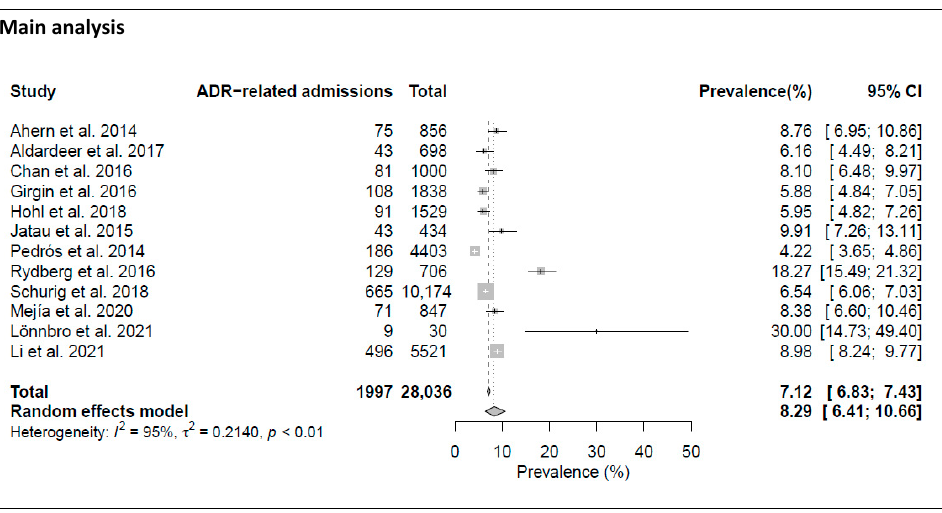
Figure 3. Forest plot of the pooled prevalence of ADE-related admissions to EDs or inpatient wards [35,39,40,42,43] . 3.6. Preventability of ADRs/ADEs Five studies found ADR preventability rates ranging from 24.0% to 97.6%, while three studies found ADE preventability rates ranging from 65.3% to 73.7% (Table 1). Preventability of ADR-related admissions . Figure 4 shows that the meta-analysis of four studies found an ADR preventability rate of 44.7% (95% CI, 28.1–62.4%) with high heter- ogeneity across studies (I 2 = 94%, p value < 0.01). Preventability of ADE-related admissions . Figure 5 shows that the meta-analysis of two studies found a preventability rate of 71.0% (95% CI, 65.9–75.6%) with low heterogeneity (I 2 = 44%, p value < 0.01).